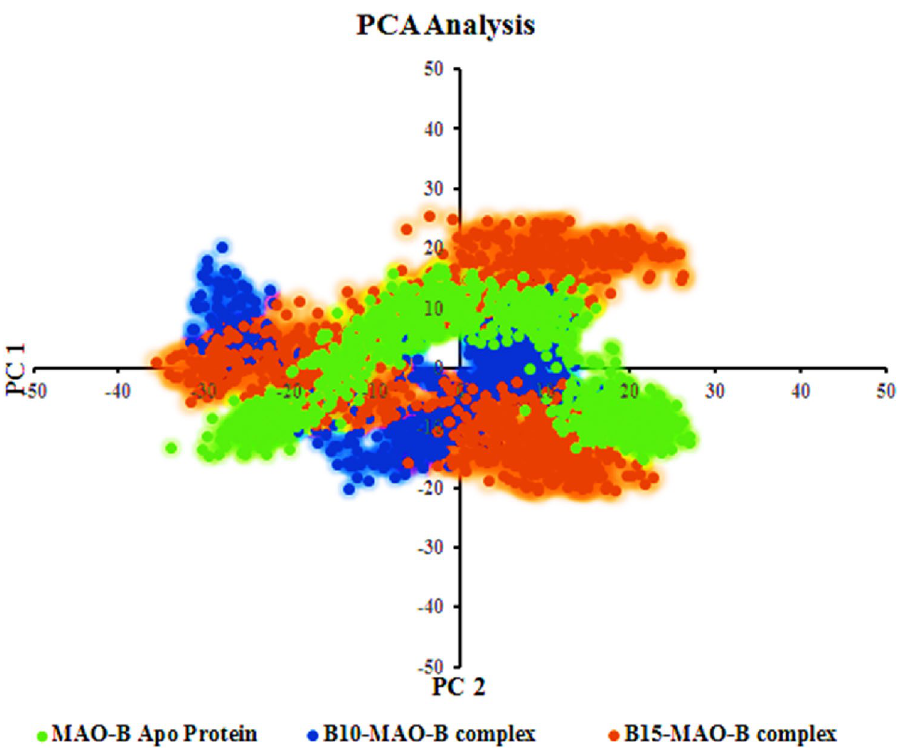
Figure 9. First two eigenvectors describing the protein motion in phase space for B10 -hMAO-B (blue) and B15 -hMAO-B (red)